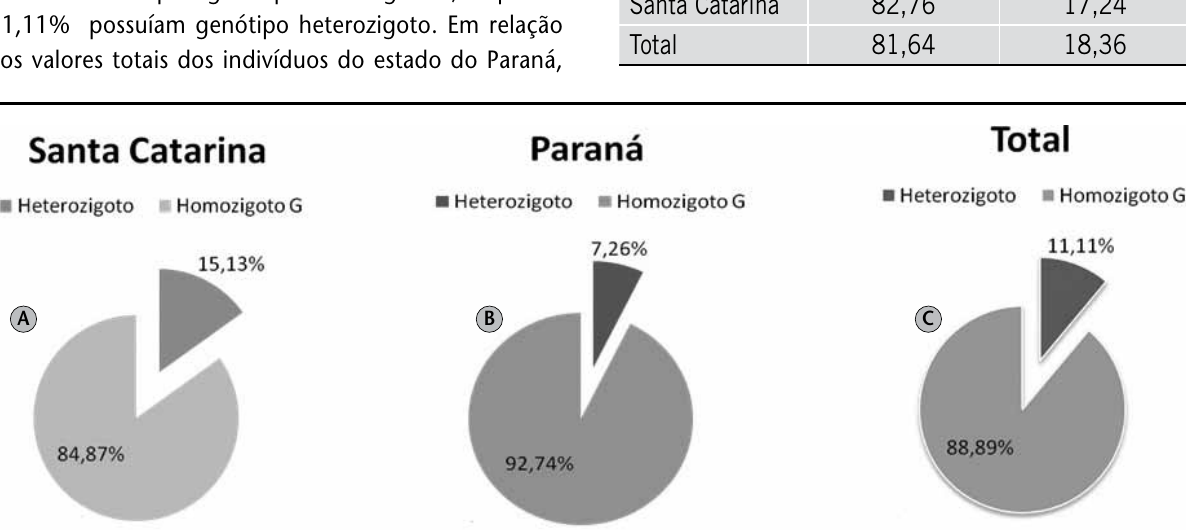
Figura – Frequência genotípica encontrada nos indivíduos dos estados de Santa Catarina e do